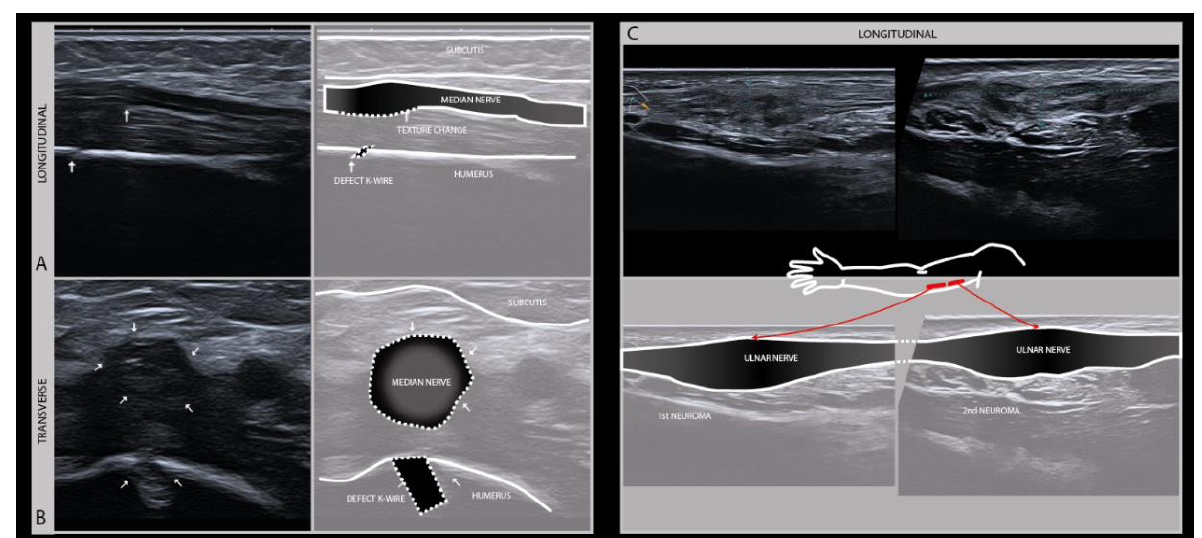
Figure 5. Longitudinal ( A ) and transverse ( B ) images of the left median nerve in the distal upper arm of a 5-year-old boy with a supracondylar humerus fracture surgically treated with K-wire fixation. The subsequent median nerve lesion with a change of nerve architecture seen near the bone defect after K-wire removal (high frequency probe 19–24 MHz). Full recovery within weeks after K-wire removal. Longitudinal ( C ) images of the ulnar nerve in the upper arm with two serial neuromas after a local gunshot wound.